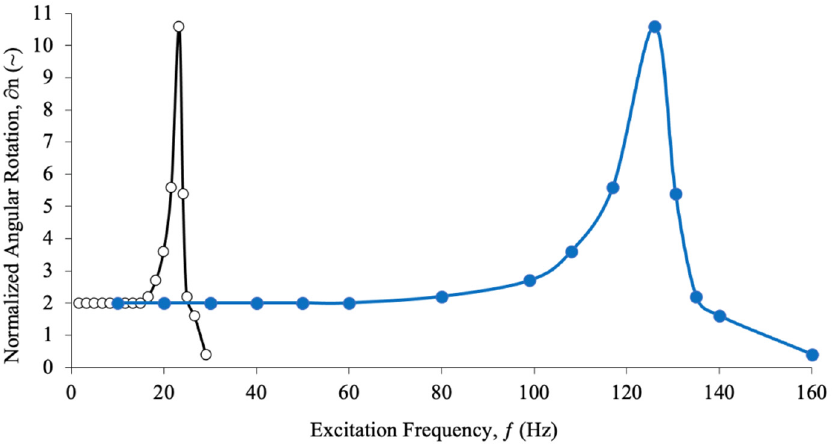
Figure 15. Open-Loop and Closed-Loop LDD Deflection Results.